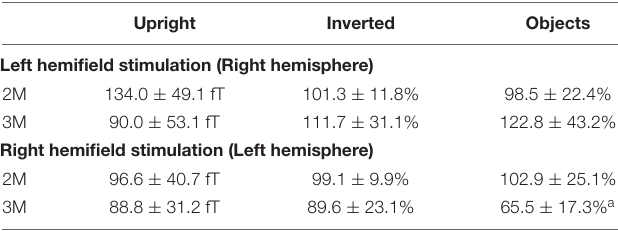
For the upright (upright face) condition, MEG data are in fT. Values for inverted (inverted face) and objects conditions are expressed as percentages after normalization with maximum amplitudes for the upright condition [adopted from Watanabe et al. (2003)].